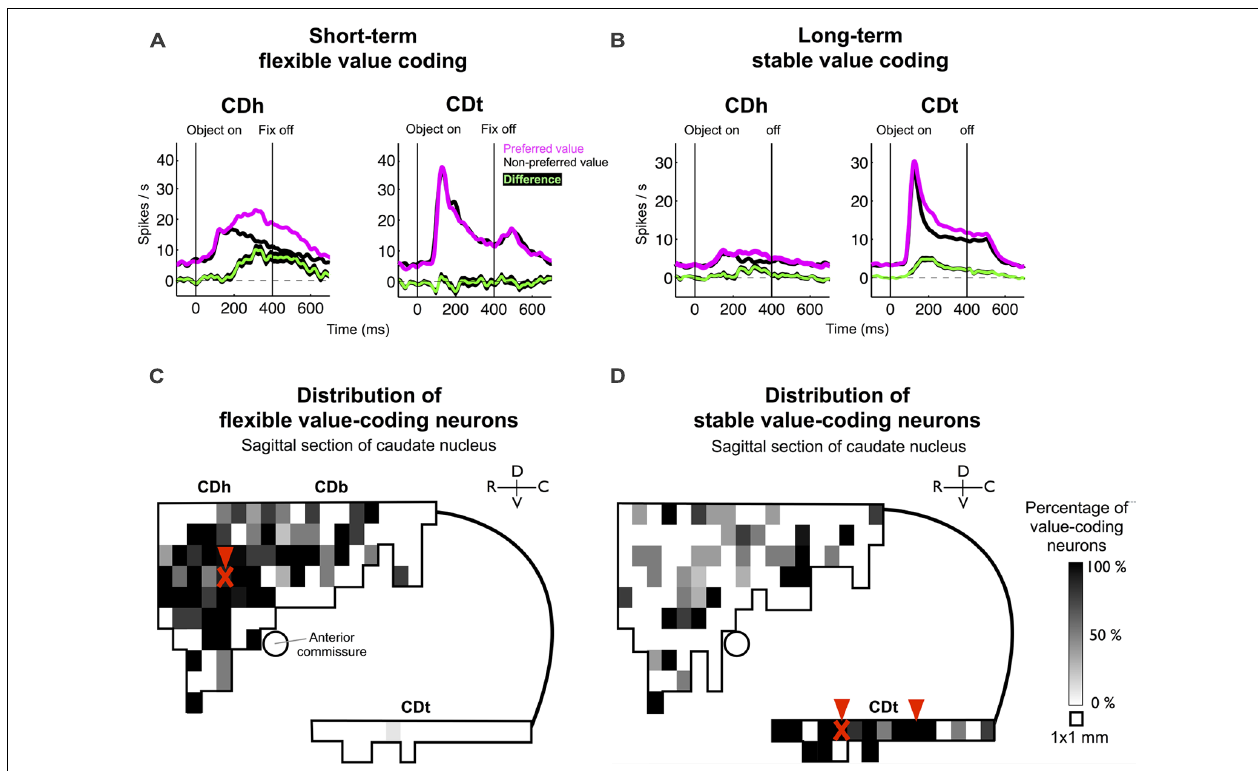
obtained from monkey SM and ZO. (C) Value-coding map for short-term flexible values. (D) Value-coding map for long-term stable values. Data in (C,D) were obtained from monkey SM, ZO, and DW. A parasagittal plane across CD was divided into 1 mm × 1 mm areas, and the percentage of neurons that encoded each type of value significantly is shown for each area. Arrowheads indicate the injection sites of retrograde tracers. “X” marks indicate the locations of muscimol injections in monkey ZO which affected gaze orienting based on flexible and stable value learning (see Kim and Hikosaka, 2013).